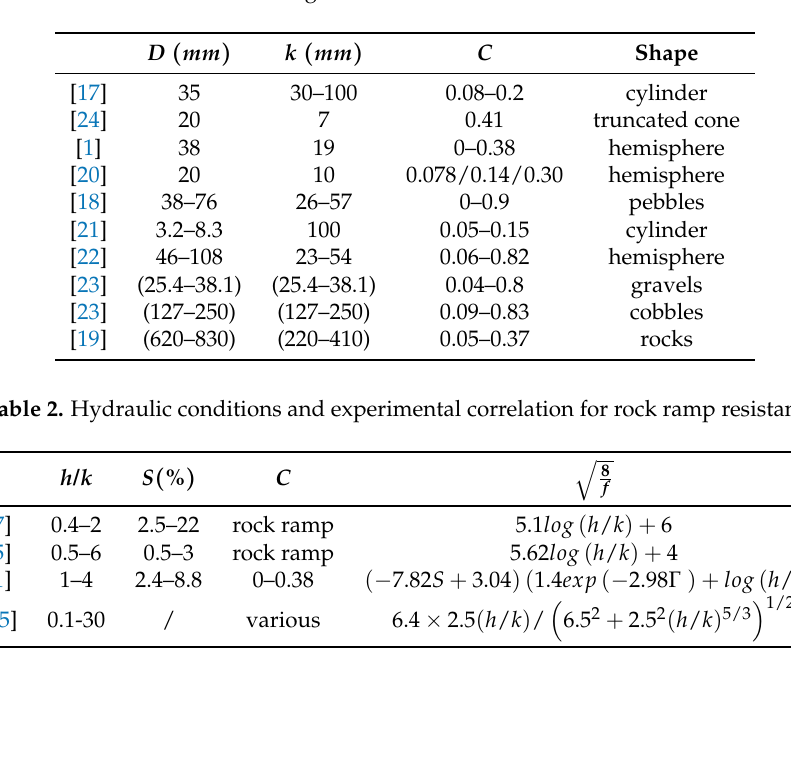
Table 1. Dimension of macro-roughness. Data from [23] are corrected with the shape factor considering that the short axis is the dimension facing the flow D .